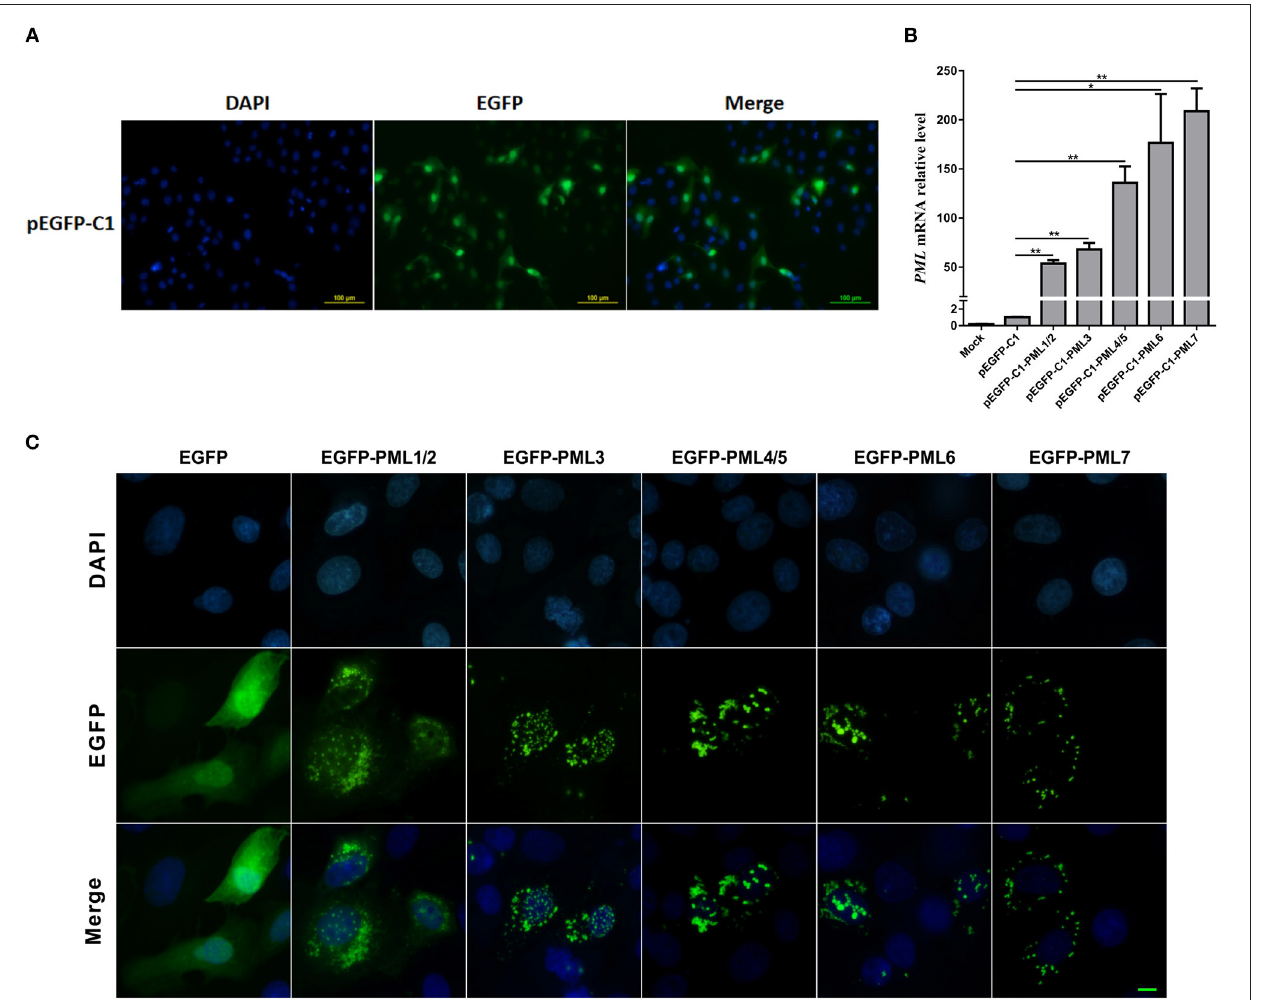
FIGURE 3 | Subcellular distribution of PML-NBs in PK15 cells after transfection of pEGFP-C1-PML isoform recombinant plasmids. PK15 cells were transfected with pEGFP-C1-PML1/2, PML3, PML4/5, PML6, and PML7 plasmids for 36h. (A) Fluorescence analysis of enhanced green fluorescent protein (EGFP) in PK15 cells transfected with the empty vector (pEGFP-C1). Nuclei were stained with DAPI (blue). (B) RT-qPCR analysis of the expression levels of PML isoforms after transfection with pEGFP-C1-PML1/2, PML3, PML4/5, PML6, and PML7. * p < 0.05, ** p < 0.01. (C) The subcellular distribution of PML-NBs in PK15 cells overexpressing different PML isoforms. Scale bar: 10 µ